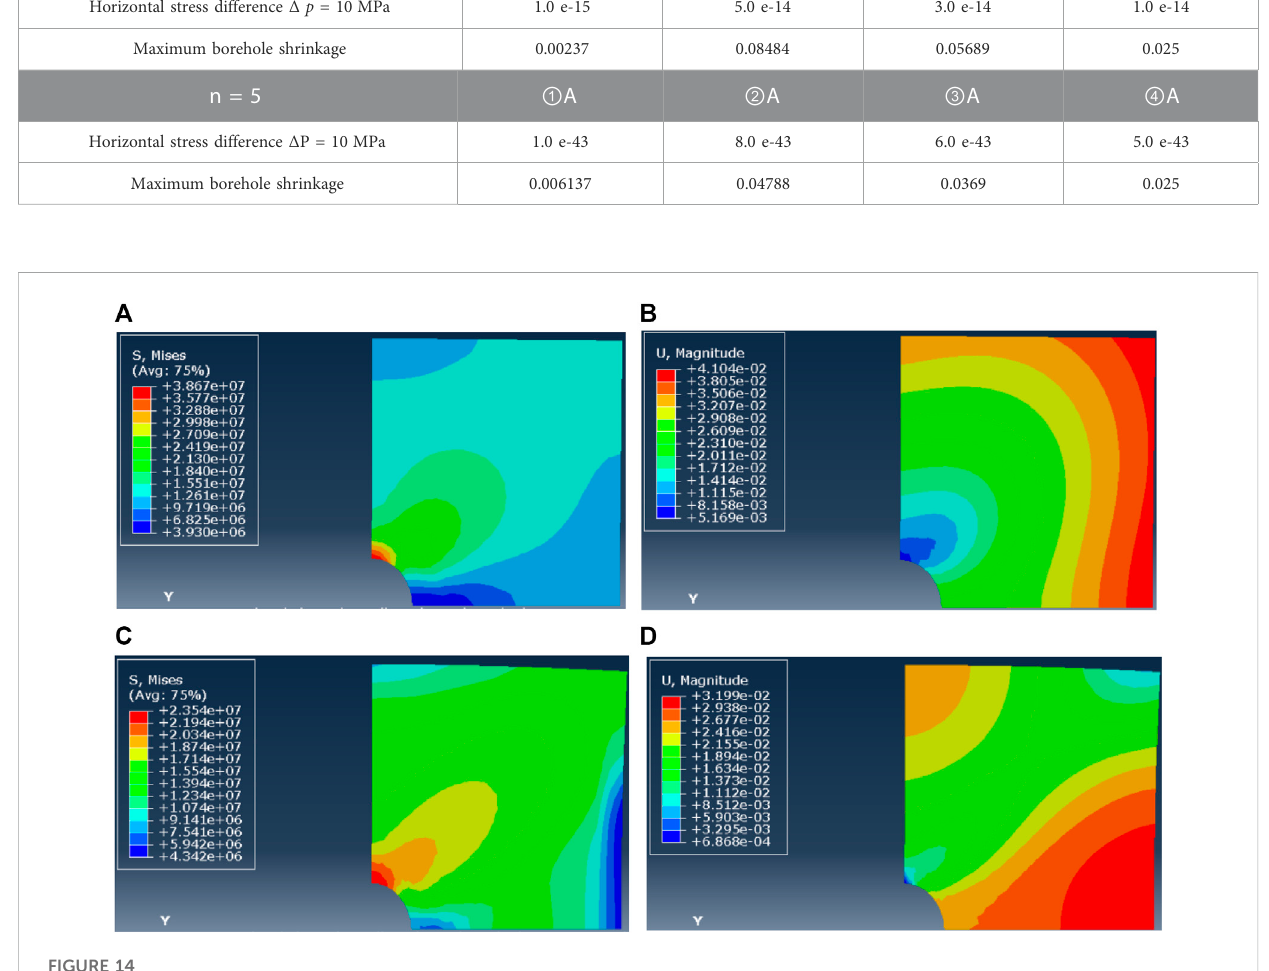
FIGURE 14 (A – D) Mises stress and displacement of borehole shrinkage after reaming ( Δ P =15 MPa, n= 1). Mises stress and displacement of borehole shrinkage after reaming ( Δ P = 15 MPa, n = 5)